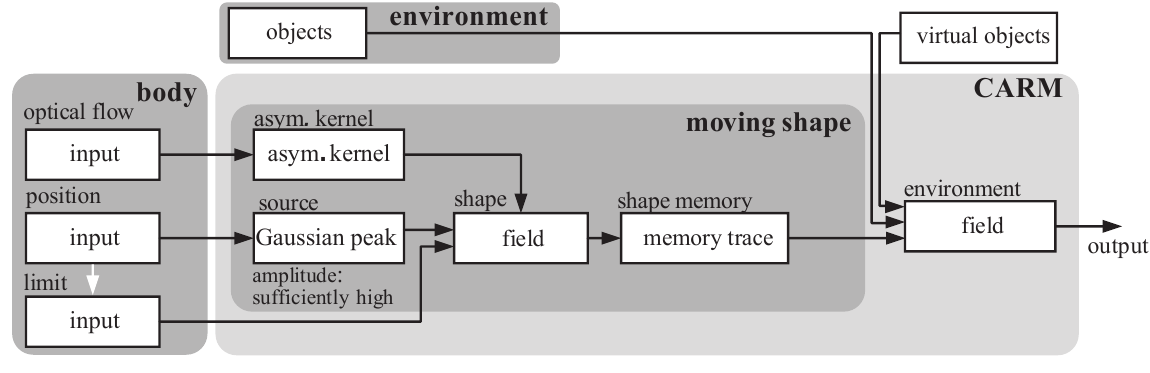
Figure 7. Architecture of the contextual action recognition module